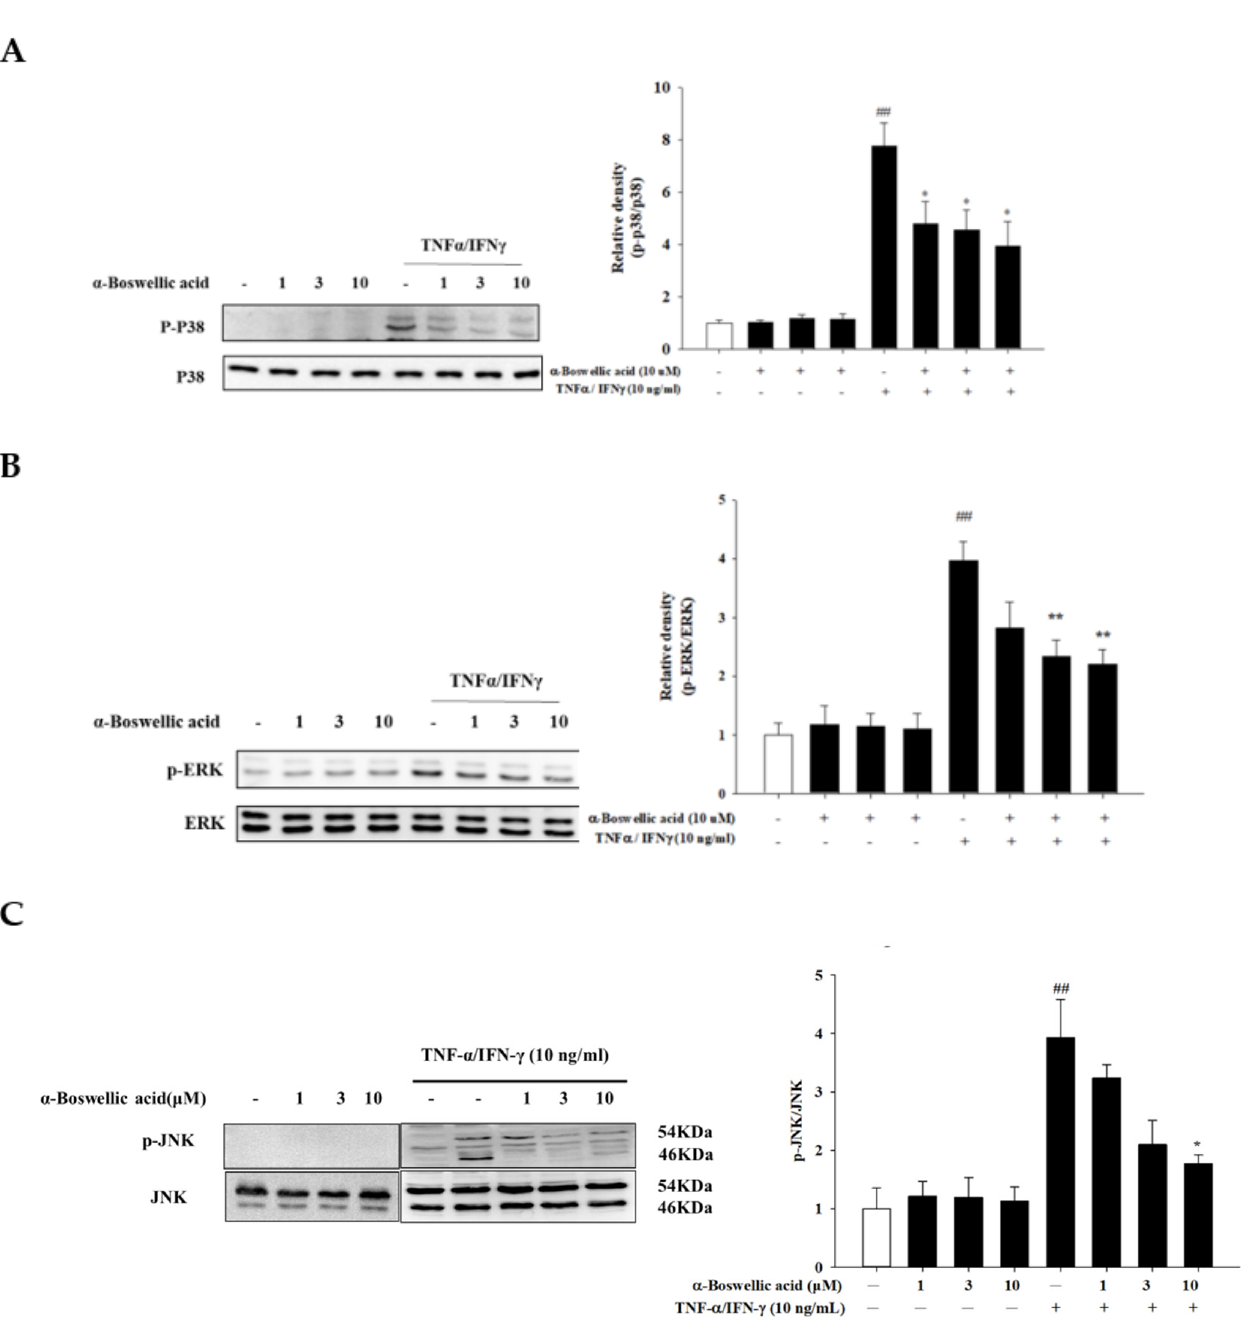
Figure 4. ( A – C ) Effects of α - boswellic acid on the MAP kinases signaling pathway in TNF- α /IFN- γ - induced HaCaT cells. HaCaT cells were pretreated with different concentrations of α -boswellic acid (1, 3, and 10 µ M) for 20 min, and then the cells were treated with TNF- α /IFN- γ for 30 min. Western blots were analyzed quantitatively. Values represent the mean ± SEM from the three independent experiments. ## p < 0.01 compared with the no-treatment condition; * p < 0.05 and ** p < 0.01 compared with the only TNF- α /IFN- γ treatment condition.